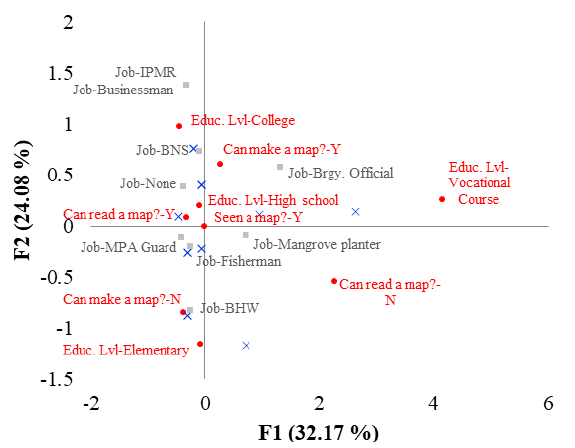
Figure 6. Symmetric plot of the first two principal coordinates relating the participants’ job, education level and mapping abilities. The ‘Y’ (‘N’) after each question indicates yes